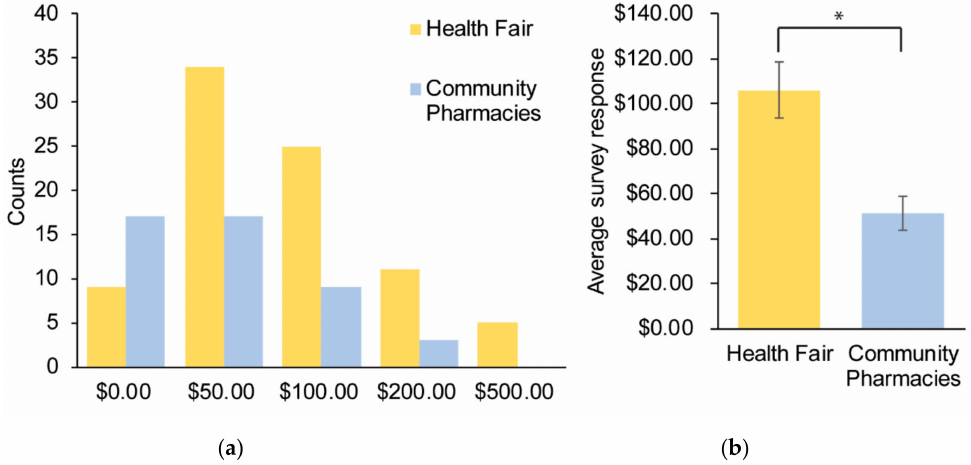
Figure 5. Survey responses to the question: “I would be willing to pay up to $____ out of pocket”. A total of 137 participants provided responses across multiple sites and were subsequently categorized as the symposium ( n = 85) and community pharmacy ( n = 52) participants. ( a ) Cumulative responses for each category depicted by di ff erent colors for the two cohorts. ( b ) The average survey response for the two cohorts. Error bars =